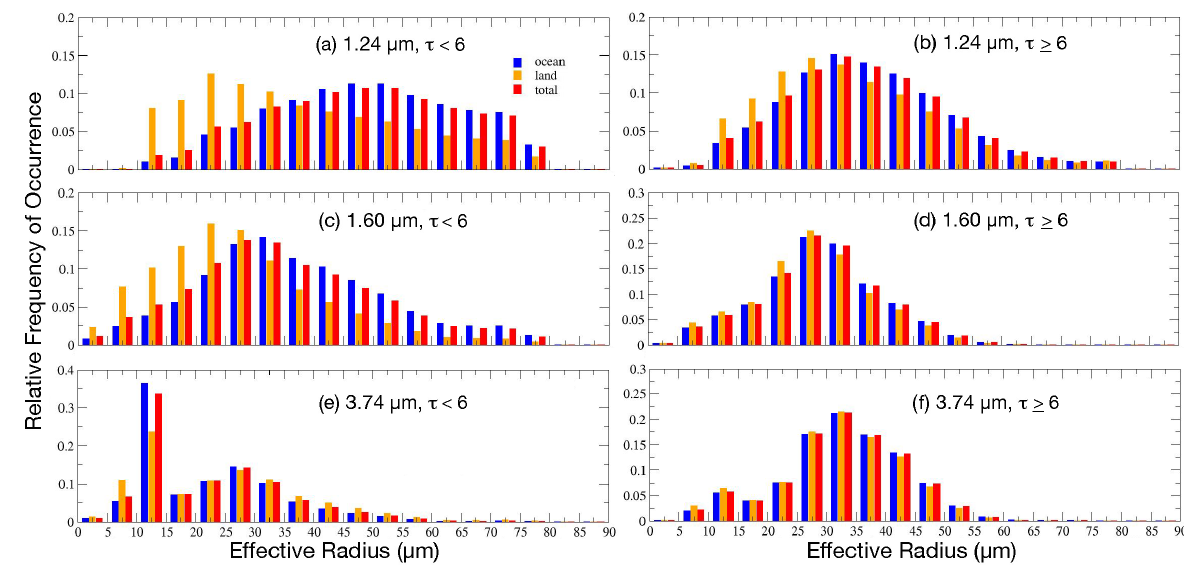
Figure 18. Same as Figure 17, except for the ice clouds.